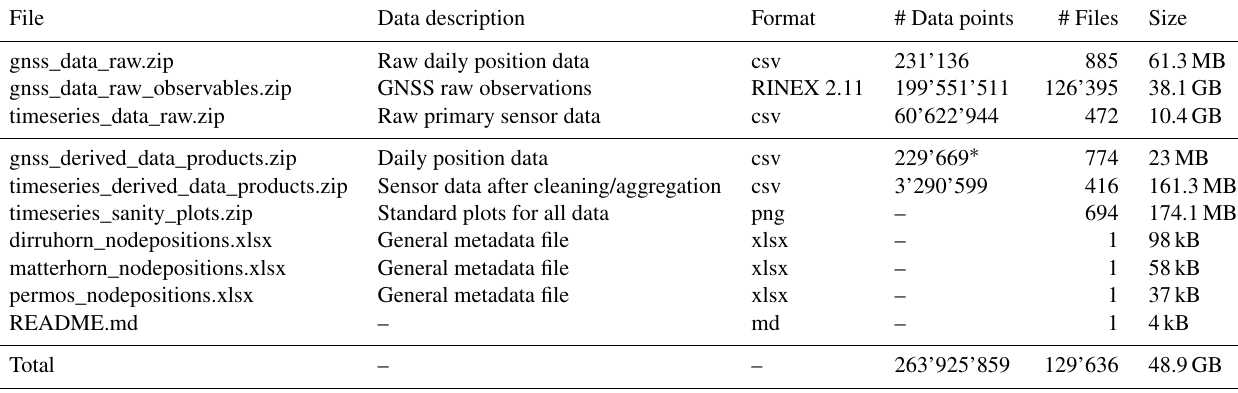
Table 3. Structure, description, formats, and sizes of the dataset